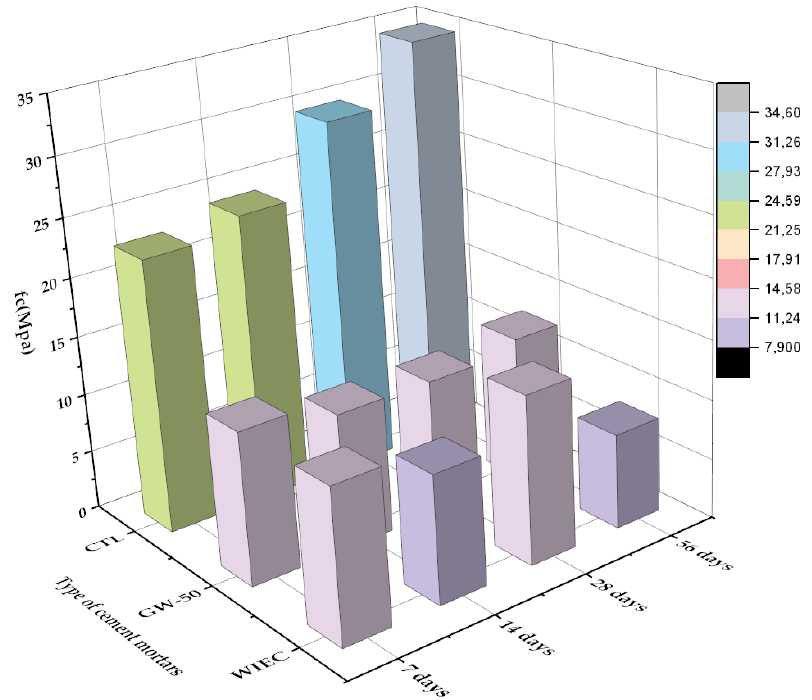
Figure 3. Compression test results for specimens with the partial replacement of sand with the GW-50 mixture and WIEC.